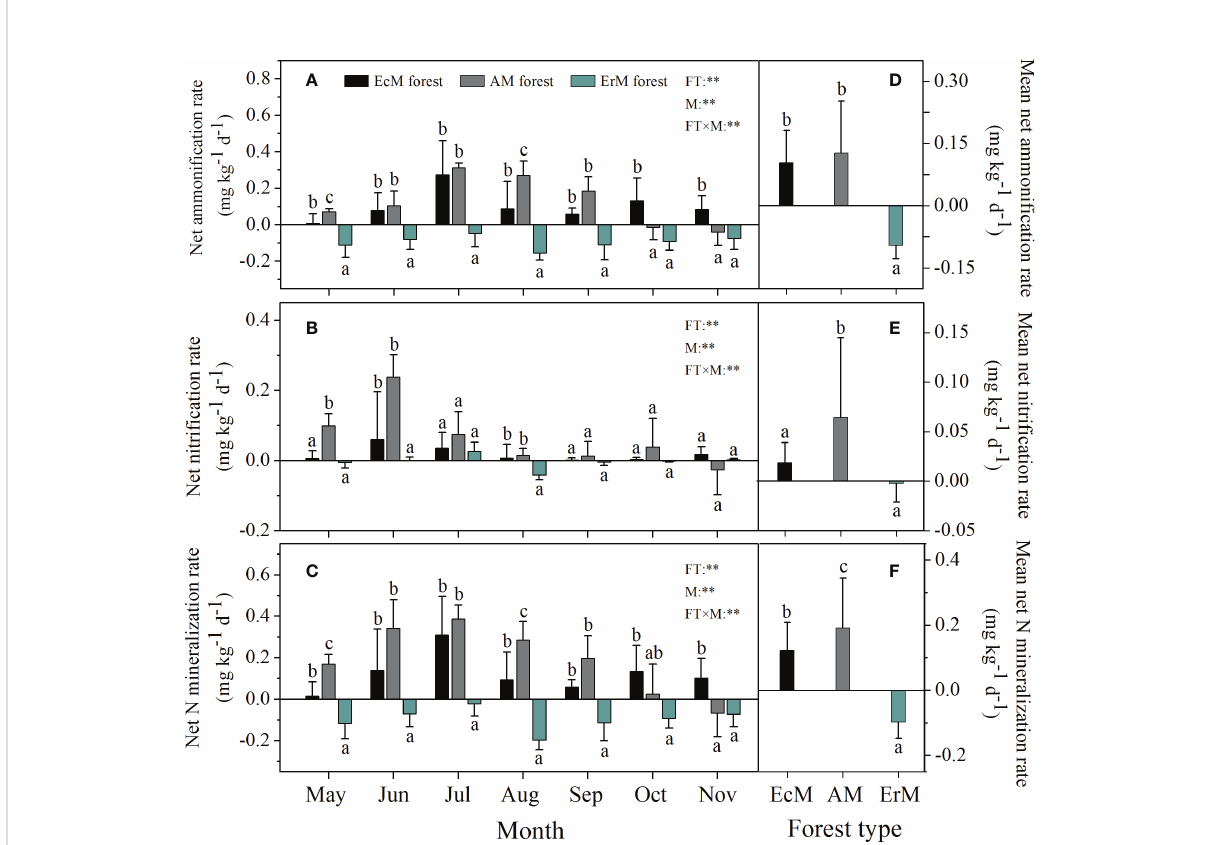
FIGURE 2 Soil net ammoni fi cation rate (A) , soil net nitri fi cation rate (B) , soil net N mineralization rate (C) varied monthly and their mean rates (D – F) among three mycorrhizal forests. Data and error bars are the means and standard errors respectively, n=8. EcM forest, Abies fargesii var. faxoniana primary forest; AM forest, Cupressus chengiana primary forest; ErM forest, Rhododendron phaeochrysum primary forest. FT, forest type; M, month; FT×M, the interaction of forest type and month. **, P < 0.01. Lowercase letters (a, b and c) indicate signi fi cant differences among three mycorrhizal forests ( P <